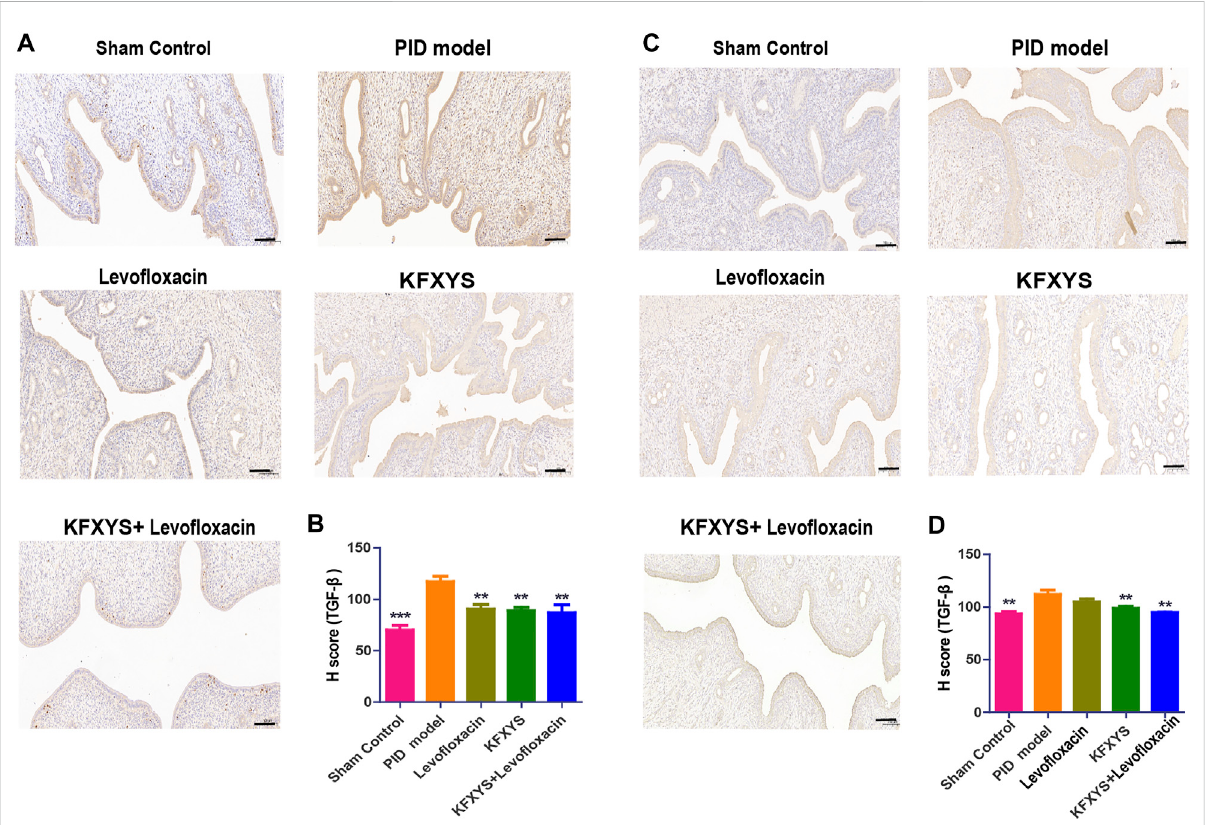
FIGURE 5 The expression of TGF- β at D14 and D49 by immunohistochemistry analysis. (A) Immunohistochemistry was used to test the protein expression of TGF- β in adhesive uterine tissue at D14. (B) Semiquantitative analysis by the H-score of TGF- β at D14. (C) The protein expression